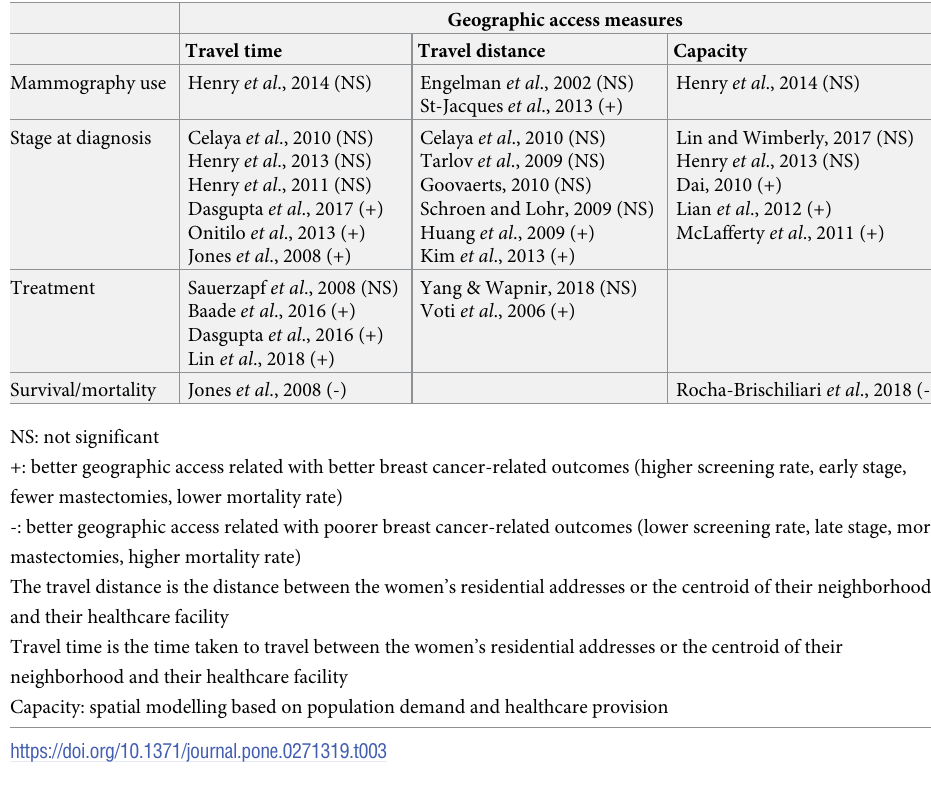
Table 3. Relations between breast cancer outcomes and geographic access to health-care